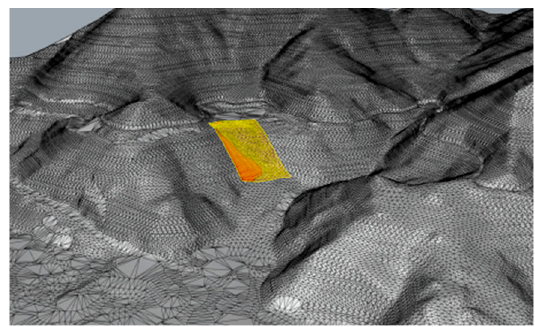
Figure 3. Three-dimensional model of the slope terrain.